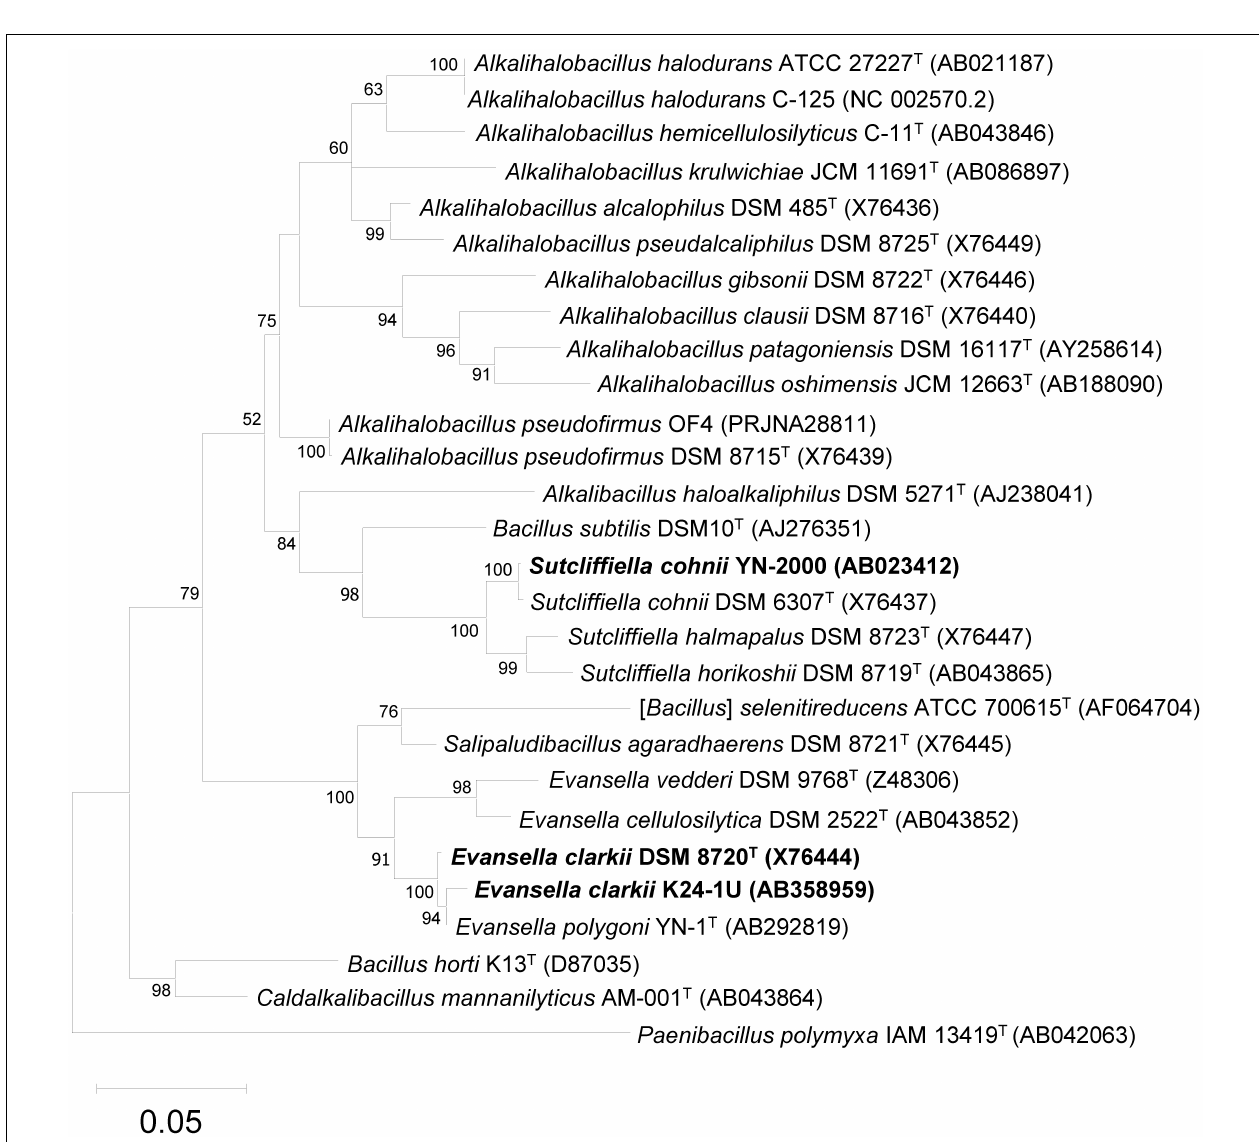
FIGURE 1 | Maximum-likelihood phylogenetic tree derived from 16S rRNA gene sequences of obligately alkaliphilic Evansella clarkii and other related alkaliphilic and neutralophilic Bacillaceae . General time reversible model (Nei and Kumar, 2000) was used as the evolutionary model. The tree with the highest log likelihood (-7837.68) is shown. Initial tree(s) for the heuristic search were obtained automatically by applying Neighbor-Join and BioNJ algorithms to a matrix of pairwise distances estimated using the maximum composite likelihood (MCL) approach, and then selecting the topology with a superior log likelihood value. A discrete gamma distribution was used to model evolutionary rate differences among sites [5 categories (+ G, parameter = 0.4765)]. The rate variation model allowed for some sites to be evolutionarily invariable [( + I), 55.96% sites]. Phylogenetic positions of the obligately alkaliphilic E . clarkii DSM 8720 T and K24-1U, and the facultatively alkaliphilic Sutcliffiella cohnii YN-2000 are indicated in bold. The bootstrap values ( > 50%) based on 1000 replications are shown at the branch node. Paenibacillus polymyxa IAM 13419 T was used as an outgroup. Bar, 0.05 substitution per nucleotide position. Evolutionary analyses were conducted in MEGA11 (Tamura et al.,